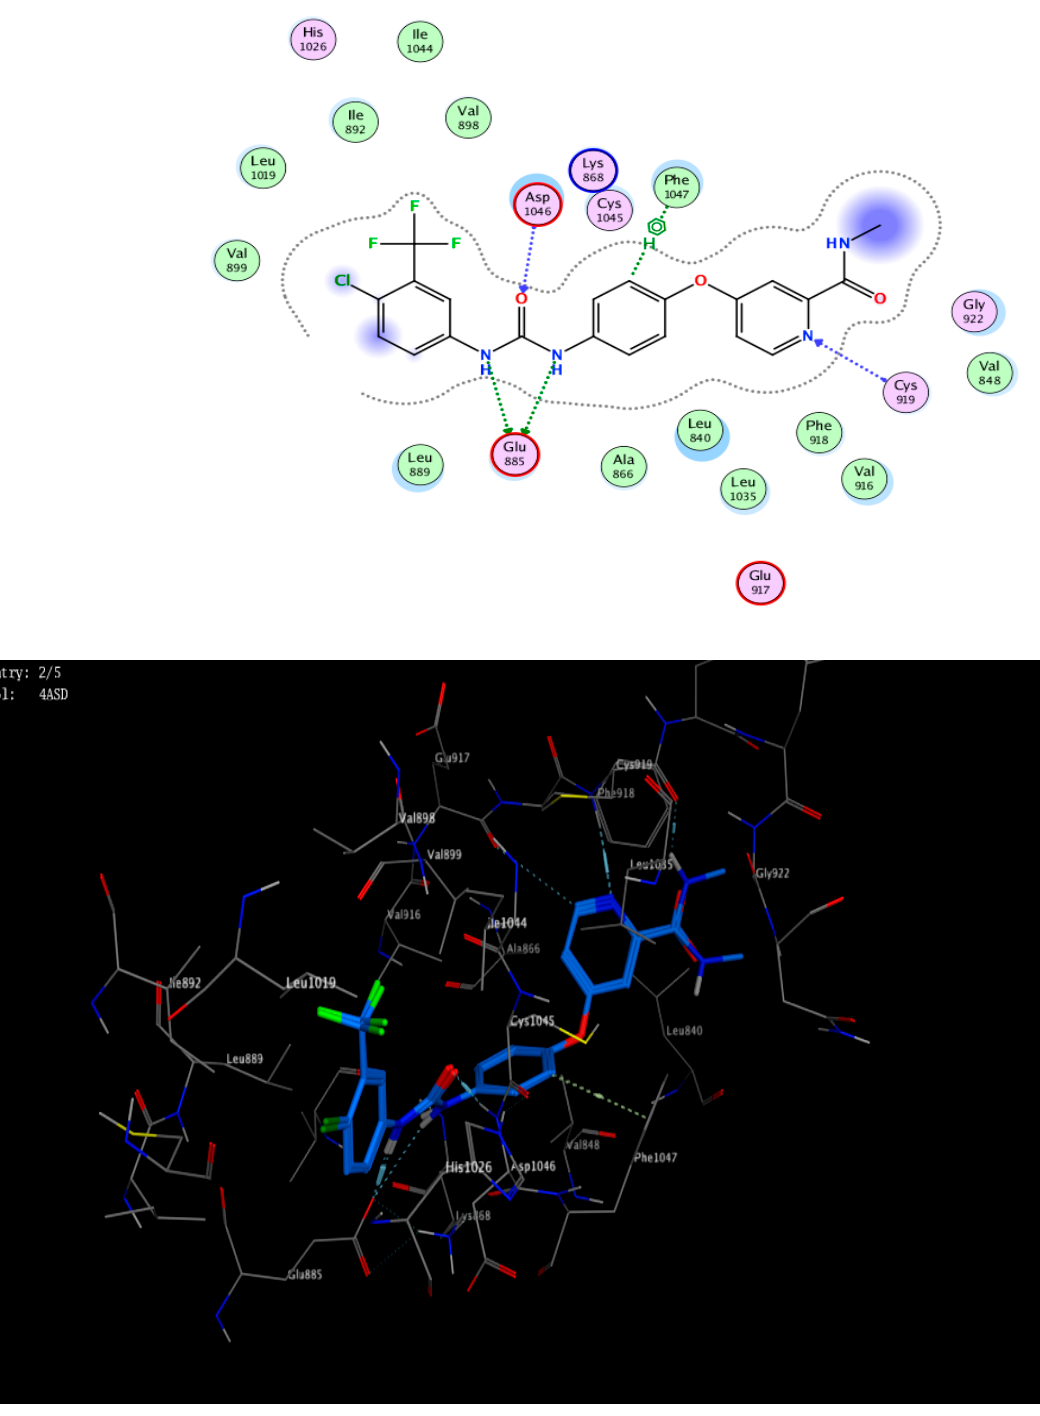
Figure 7. Two-dimensional and three-dimensional models of the binding of Sorafenib with the active site of VEGFR-2. site of